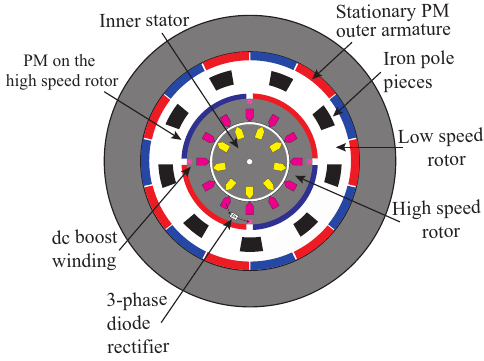
Figure 2. Magnetically Geared Induction